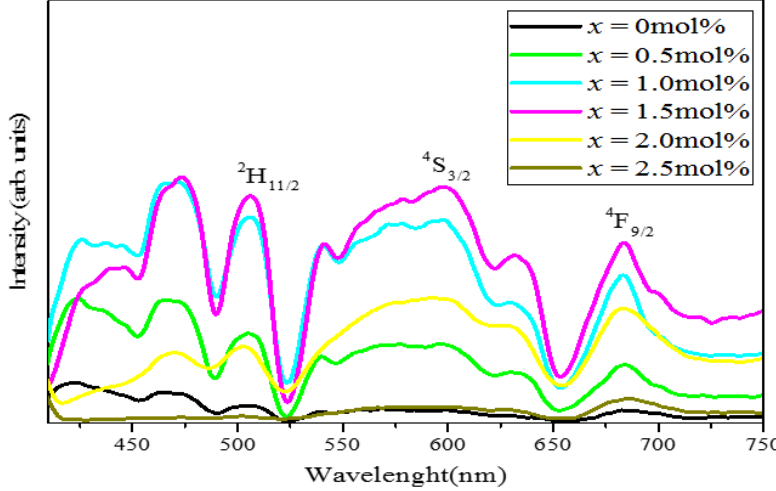
Figure 10. Emission spectra of all glass samples with excitation wavelength at 800